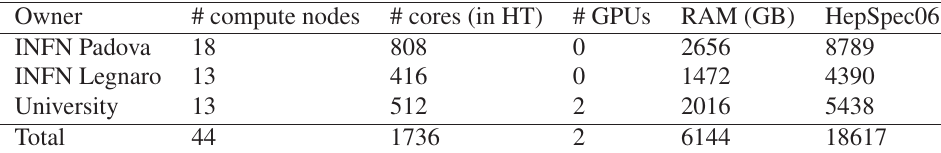
Figure 3. The architecture of CloudVeneto.it. Table 1. CloudVeneto.it computing